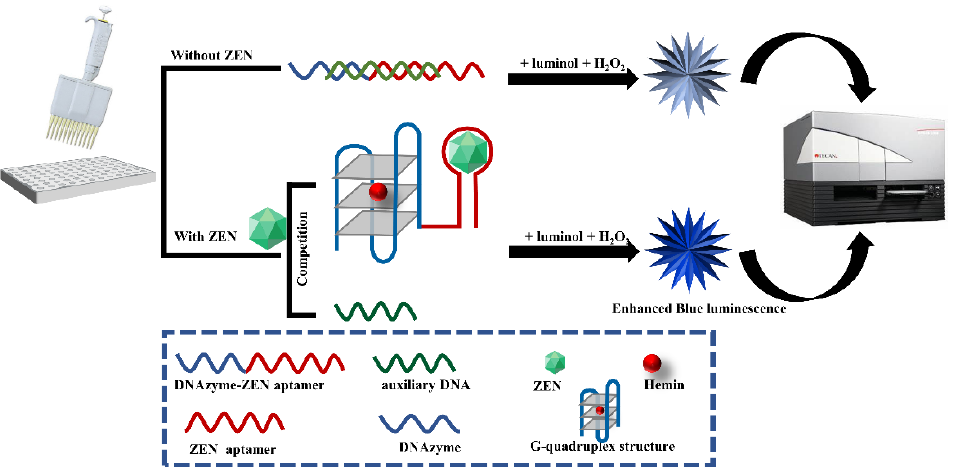
Figure 1. Schematic diagram of label-free and chemiluminescence detection of ZEN based on a DNAzyme – aptamer conjugate. In the absence of ZEN, DNAzyme – ZEN aptamer forms a double helix with the auxiliary DNA, leading to inactivity of the DNAzyme and subsequent weak luminescence emission upon luminol and H 2 O 2 addition. In the presence of ZEN, it can displace the aptamer from the double helix of the DNAzyme – ZEN aptamer and the auxiliary DNA, resulting in binding of the DNAzyme to hemin and subsequent strong luminescence generation upon luminol and H 2 O 2 addi- tion.